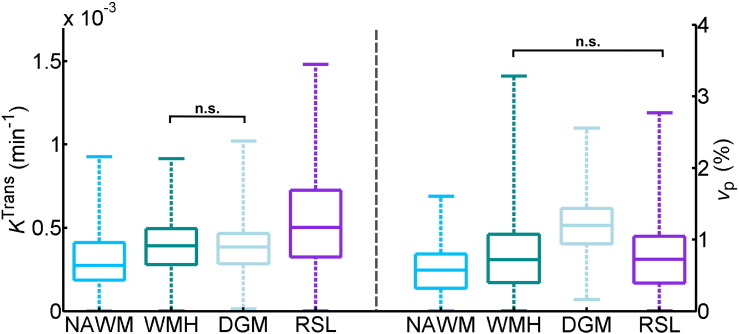
Comparison of fitted Patlak parameters between tissue types. Box plots showing the distribution of KTrans (left) and vp (right) in normal-appearing white matter (NAWM), white matter hyperintensities (WMH), deep grey matter (DGM) and recent stroke lesions (RSL). Brackets with n.s. indicate non-significant differences with p > 0.5; all other differences between tissue types are significant with p < 0.001 (brackets omitted for clarity).